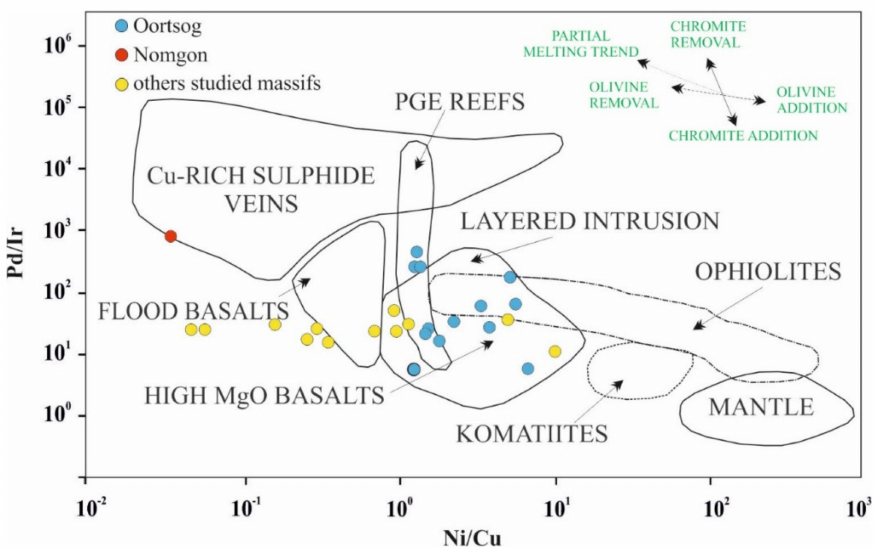
Figure 12. PlotofPd / Irvs. Ni / CuforrocksfrommassifsoftheKhangaiupland.